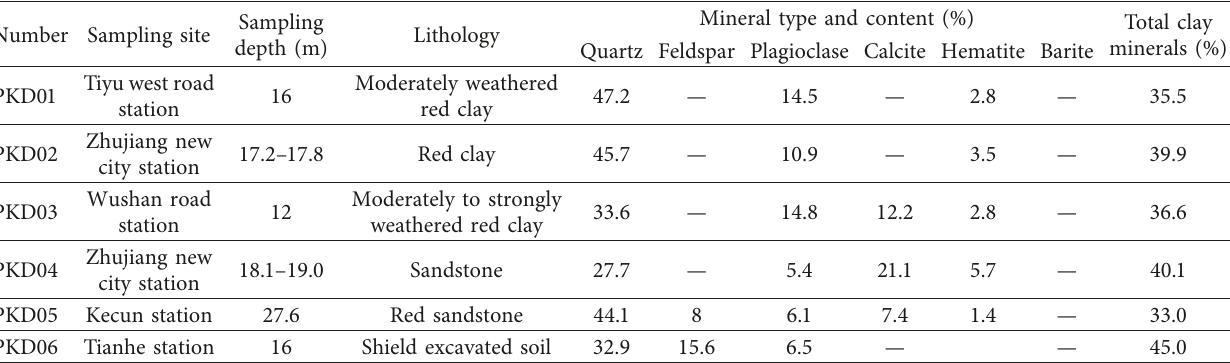
Table 3: All mineral XRD test